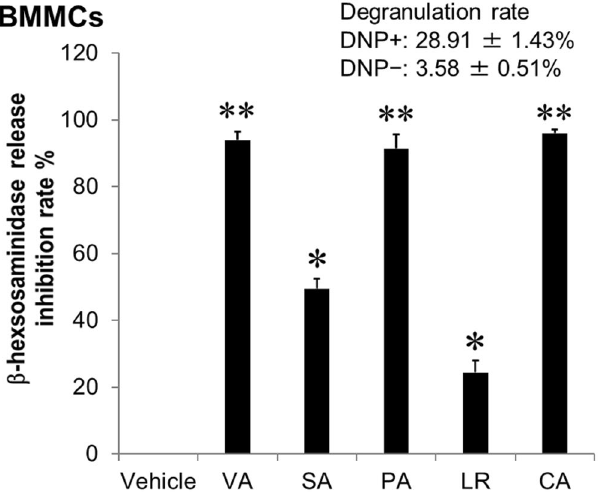
Figure 5. Inhibitory effects of active compounds derived from ume on antigen-induced degranulation of BMMCs. IgE-sensitized BMMCs were stimulated with DNP-BSA in the presence of active compounds derived from ume seed at 600 μ M or vehicle (0.1% DMSO). Data represent the mean ± SD (n = 3) of β -hexosaminidase release inhibition rate of three independent experiments. Degranulation rates of maximum response when cells are treated with vehicle and DNP-BSA (DNP + ) or minimum response when cells are treated with vehicle alone (DNP-) are shown in the figures. * p < 0.05, ** p < 0.001, compared with β -hexosaminidase release inhibition rate of vehicle.